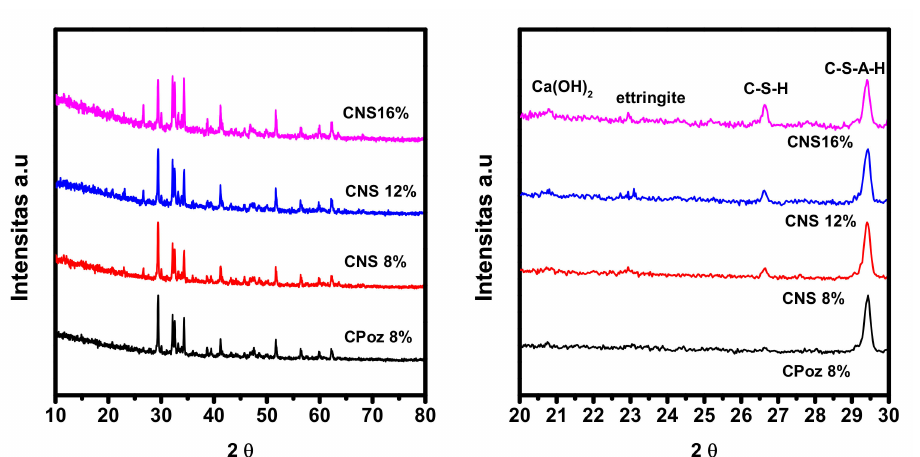
Figure 11. XRD analysis of portland composite cement based on pozzolan Napa soil on day 28. The effect of increasing temperature on the mass loss (weight loss) of the sample and determining the temperature of the decomposition process of the cement sample using TGA analysis is shown in Figure 12.